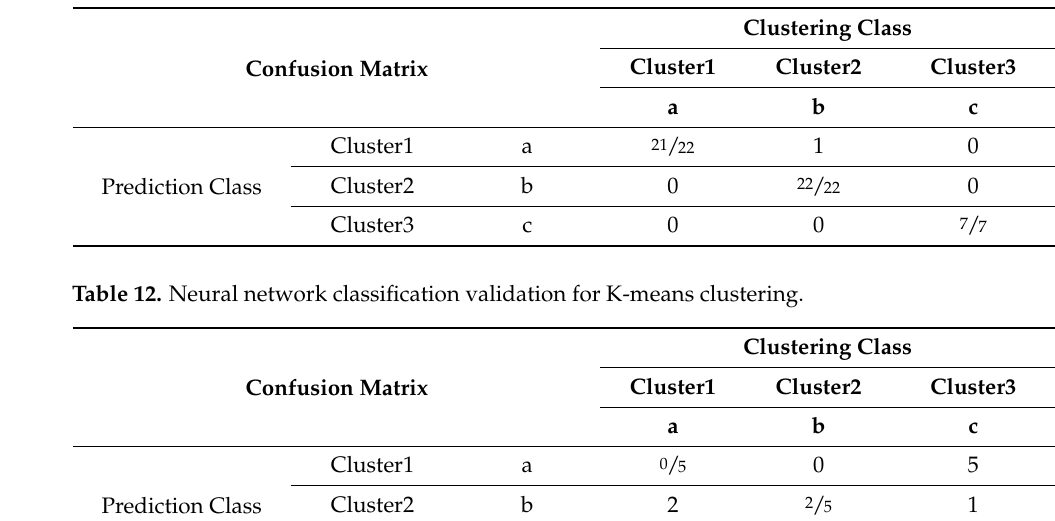
Table 11. Random forest classification validation for Cascade K-means clustering.